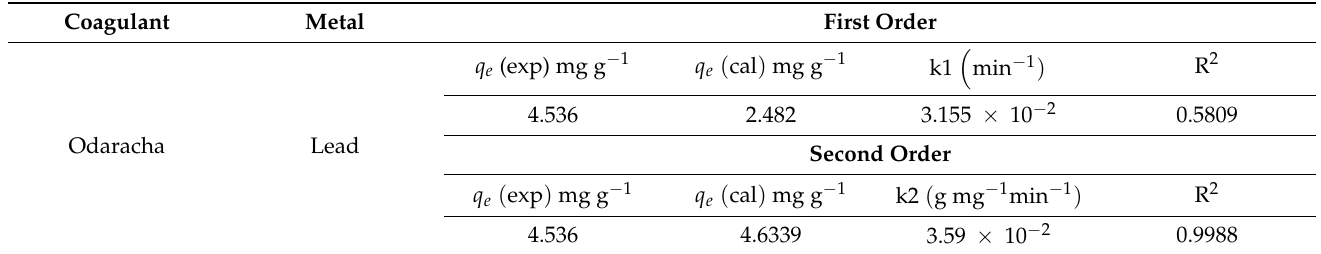
Figure 9. Pseudo-second-order kinetics plots for the adsorption of Pb 2+ ions onto Odaracha adsorbent. Table 7. Line fit model of Pseudo first and second-order kinetics for Pb 2+.